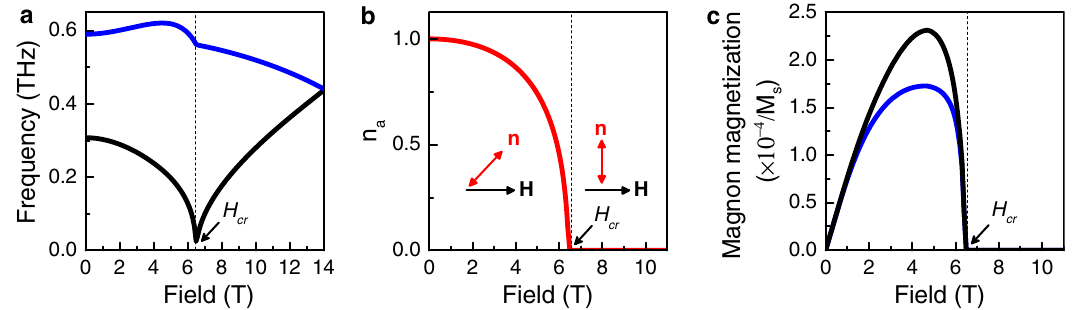
Fig.4|Characteristicsoftwomagnoneigenmodesforamagnetic fi eldapplied along the a-axis. a Field dependence of the eigen-frequencies for two magnon eigenmodes. Softening of the low frequency eigenmode takes place for H = H cr . b Component of the Néel vector along a -axis as a function of fi eld applied along easy-axis, indicating a smooth orientation of Néel vector towards the c -axis. The